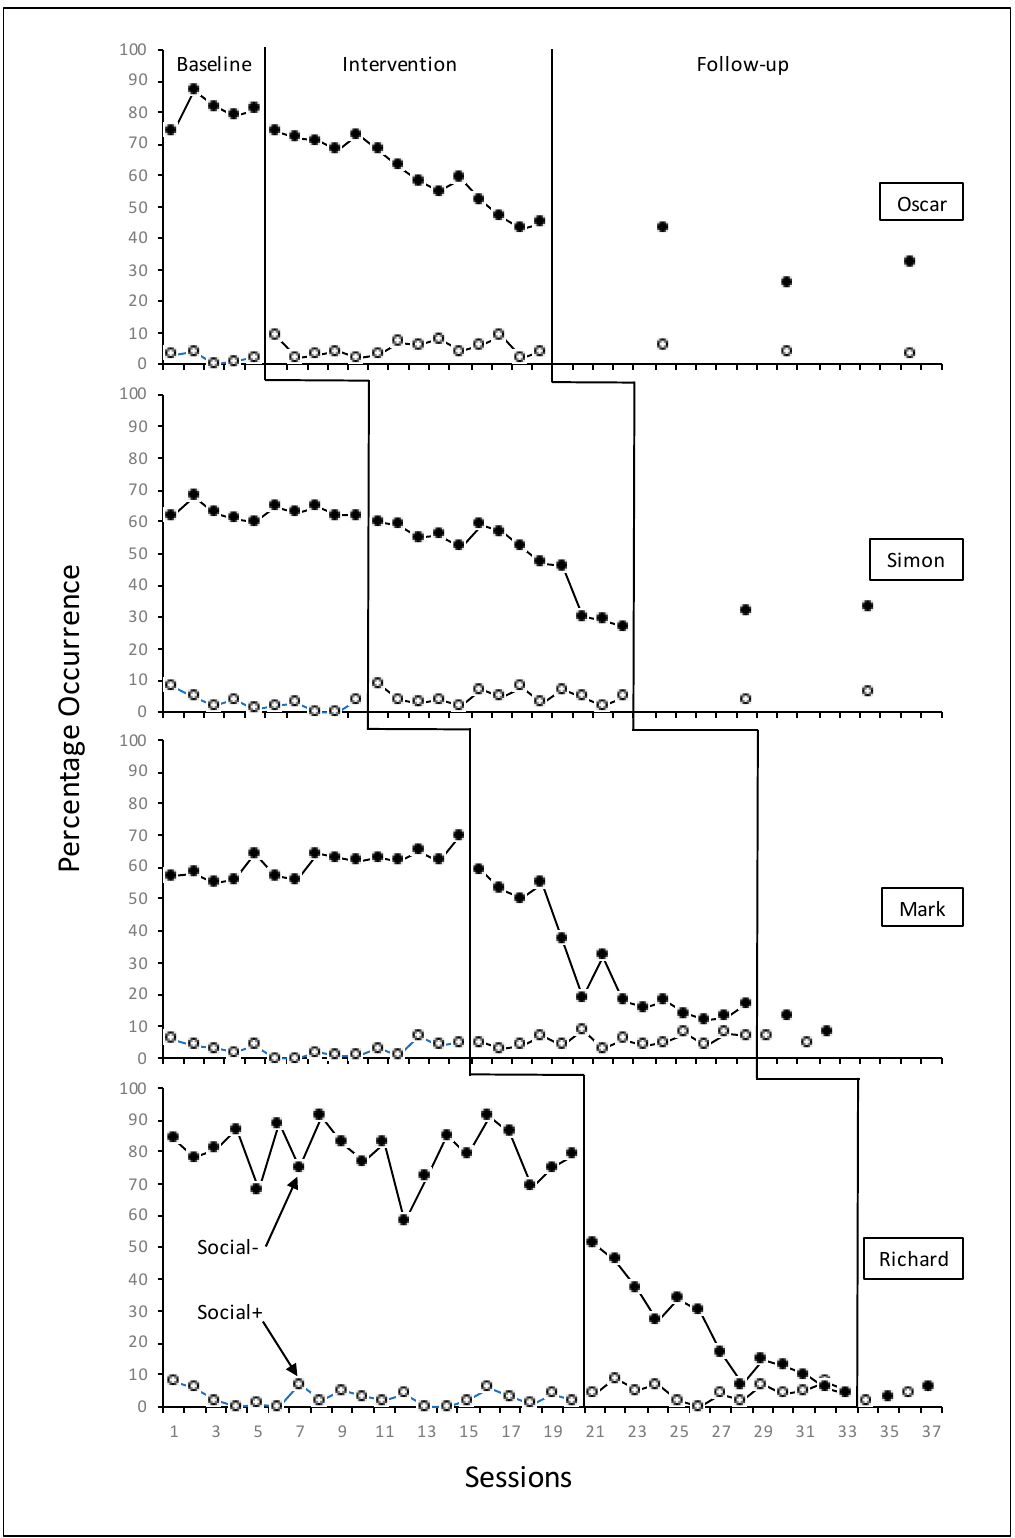
Figure 2. Percentage of 10 s intervals of teacher social contact during 20 min classroom observations across all phases.